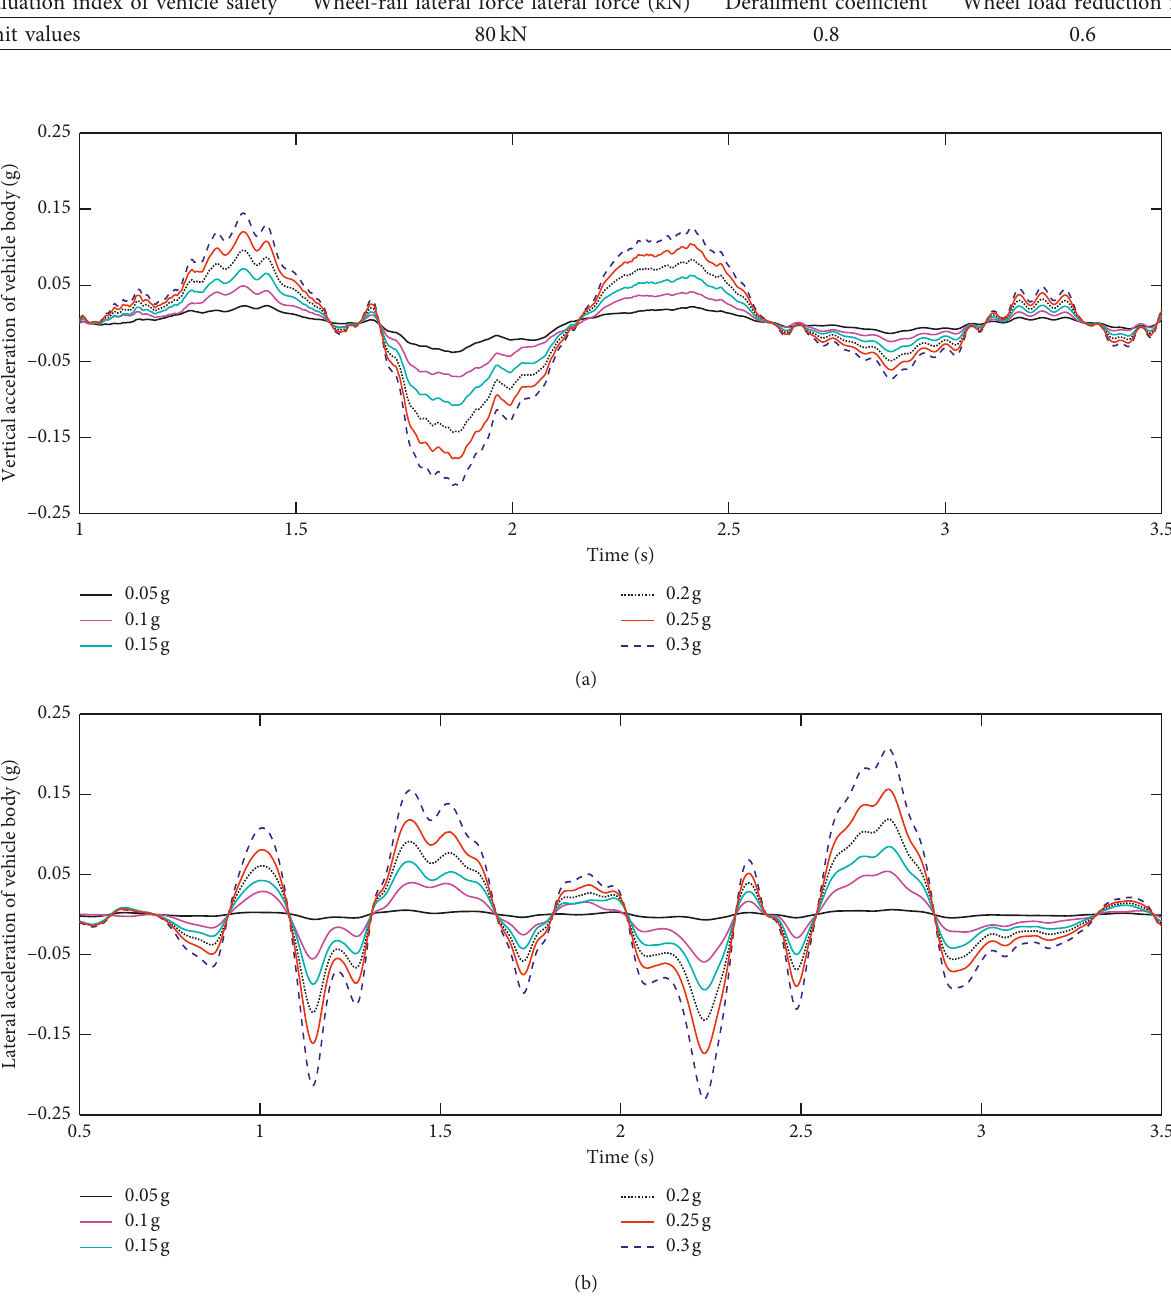
Figure 6: The time history curve of vertical and lateral accelerations of vehicle body under different seismic intensities. (a) Vertical acceleration of vehicle body. (b) Lateral acceleration of vehicle body.